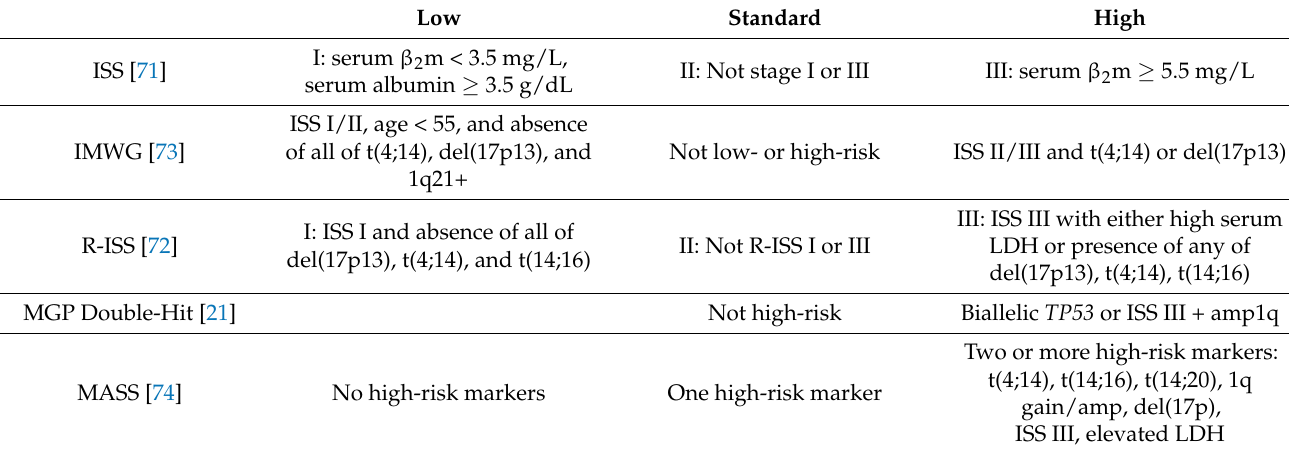
Table 1. Risk stratification in multiple